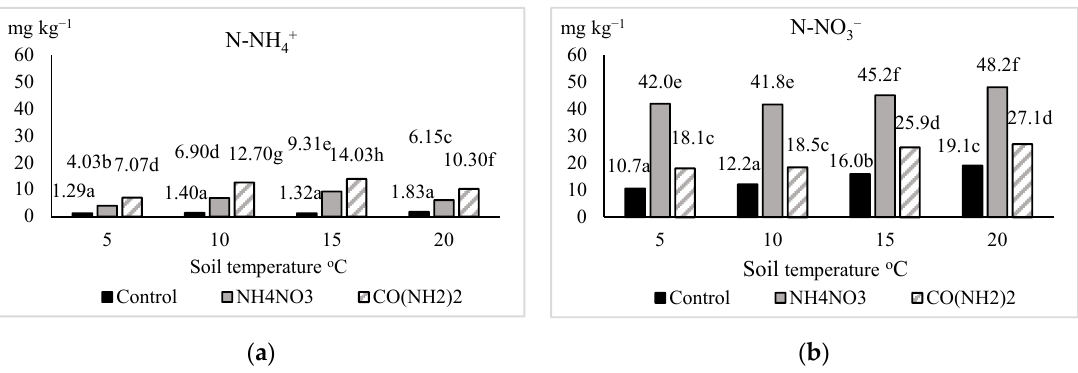
Figure 1. The influences of nitrogen fertilizer forms and ambient temperatures on the changes of ( a ) N-NH 4 + and ( b ) N-NO 3 − in the 0–15 cm soil layer with a simulated precipitation of 10 mm. Values followed by different letters are significantly different ( p ≤ 0.05) based on Fisher’s LSD test. + ◦ ◦ − As the soil temperature increased from 5 C to 15 C, both the N-NH 4 and N-NO 3 levels in